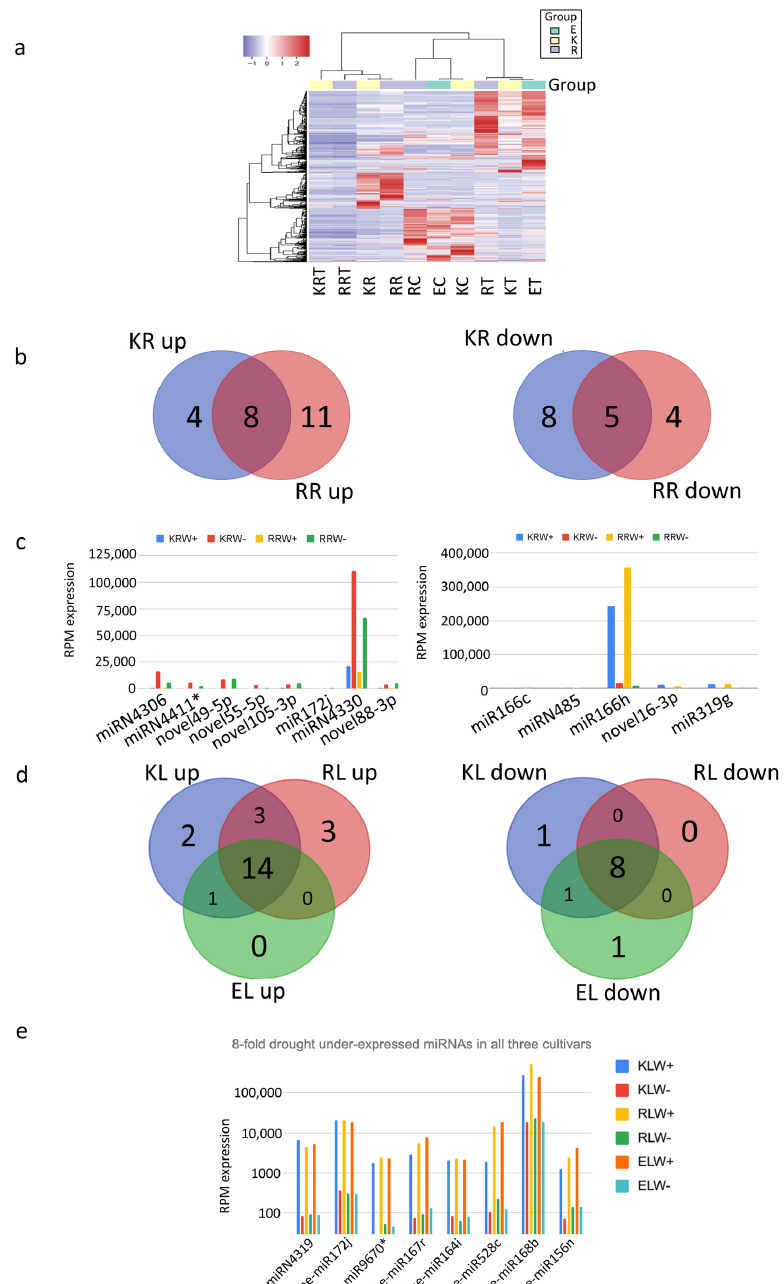
Figure 4. Differential expression of miRNAs analysed with ( a ) heatmap using log(RPM) values, ( b , d ) Venn diagrams and ( c ) RPM expression. I( e ) miRNAs that have an 8-fold drought downregulation.